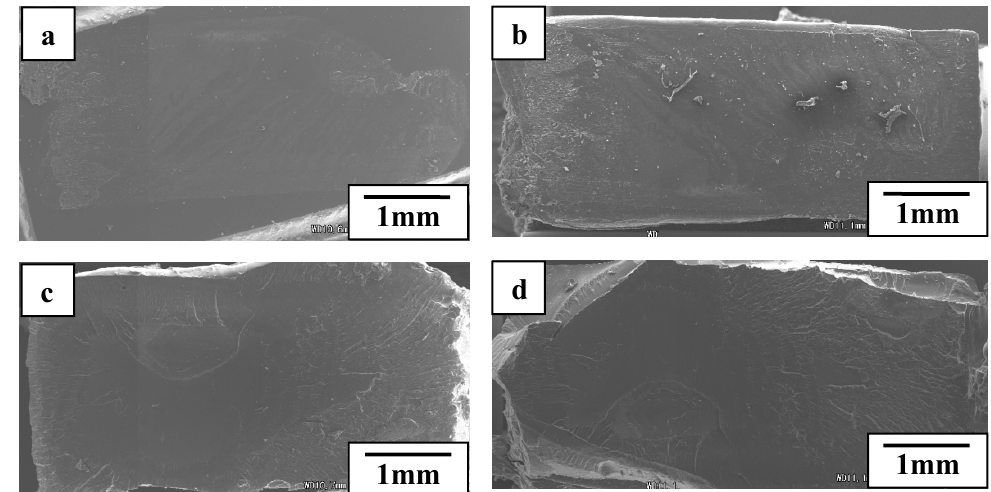
Figure 17. Rupture surfaces of welded interface between POM and PLA under welding pressure of 0.4 MPa. ( a ) is POM side at welding time of 1 s, ( b ) is PLA side at welding time of 1 s, ( c ) is POM side at welding time of 2 s and ( d ) is PLA side at welding time of 2 s. Adapted from Reference [150]. 5. Ultrasonic TWTP Technology of PLA and PMMA